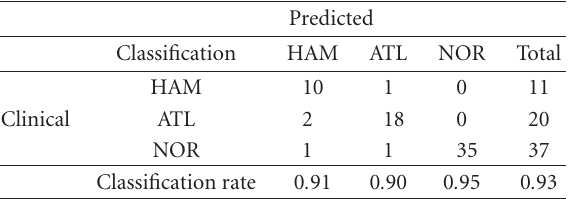
Table 2. Confusion matrix to show the performance of δ B using